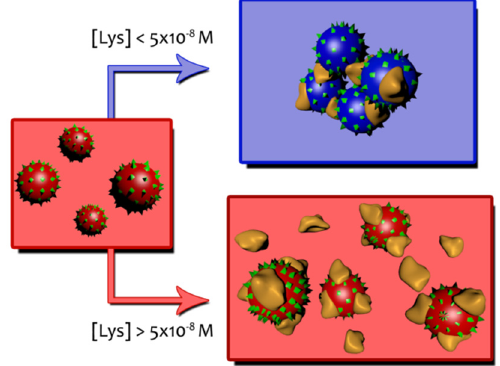
Scheme 1. Schematic representation of AuNPs/Lys entities.